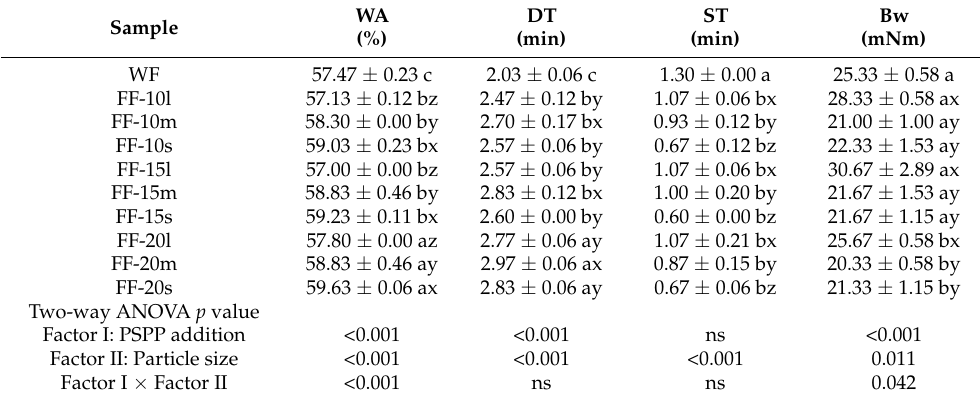
Table 3. Mixing properties of formulated flours influenced by different particle size distributions and addition levels of